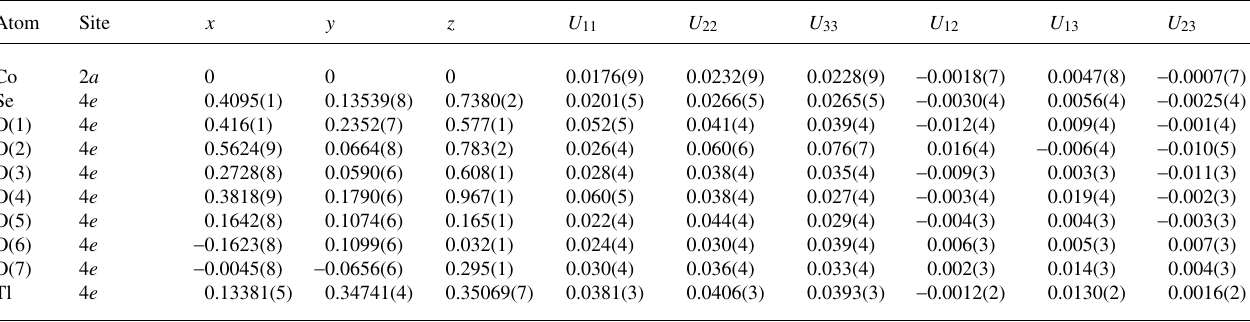
Table 9. Atomic coordinates and displacement parameters (in Å 2 )